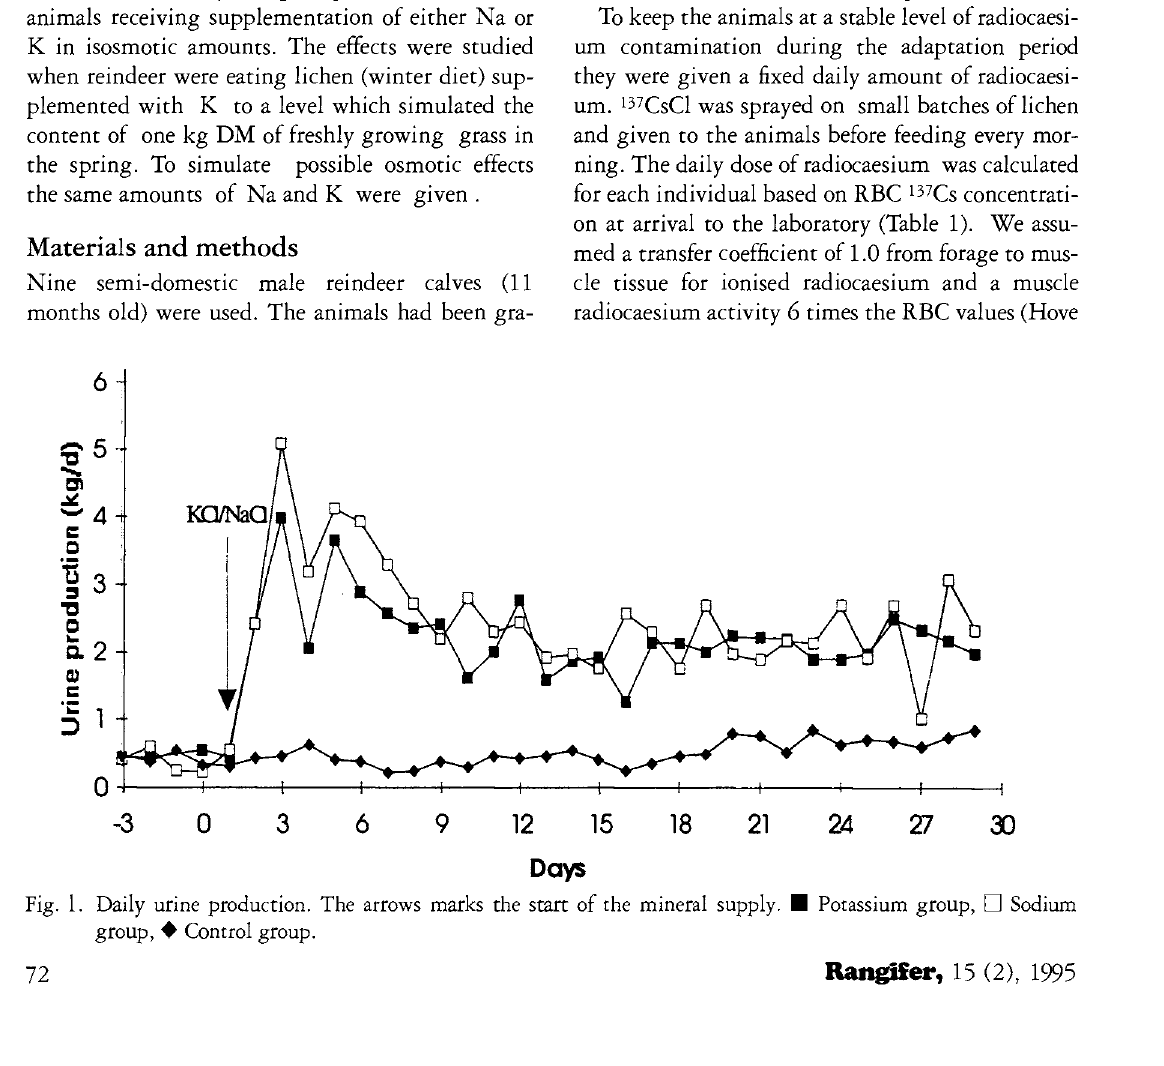
Fig. 1. Daily urine production. The arrows marks the start of the mineral supply. • Potassium group, • Sodium group, • Control